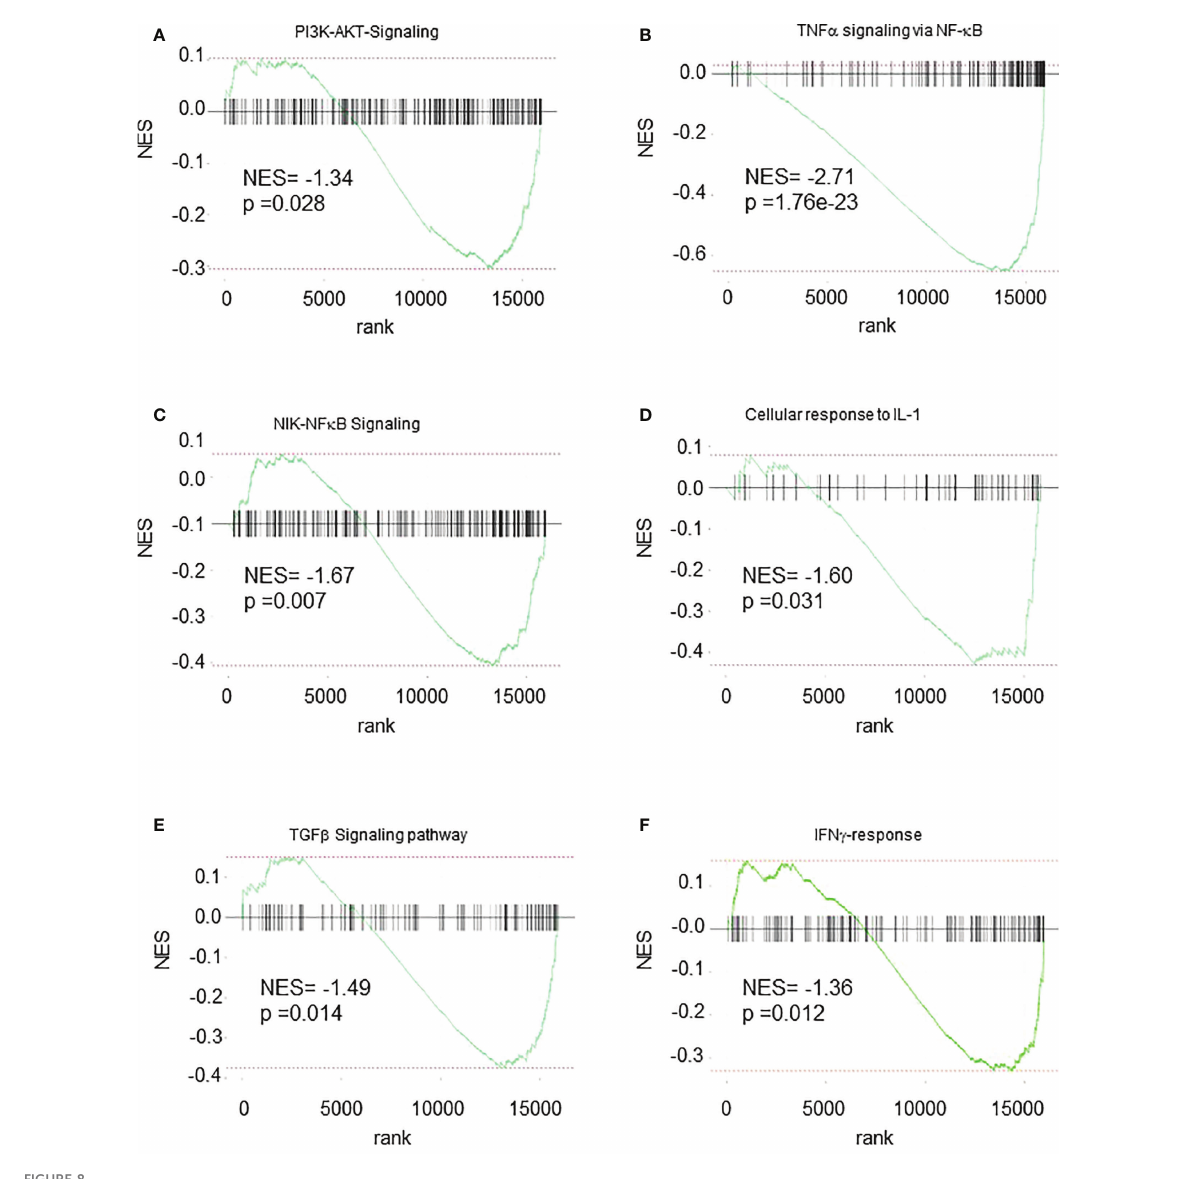
FIGURE 8 Multiple pathways are down-regulated in Spleen Cxcr2-/- neutrophils. GSEA analysis of the following signatures: (A) WIKI-PI3K-AKT signaling. (B) Hallmark-TNF a signaling via NF k B. (C) GO-BP NIK-NF k B Signaling (D) GO-BP Cellular response to IL-1 (E) WP-TGF b signaling pathway (F) Hallmark IFN g